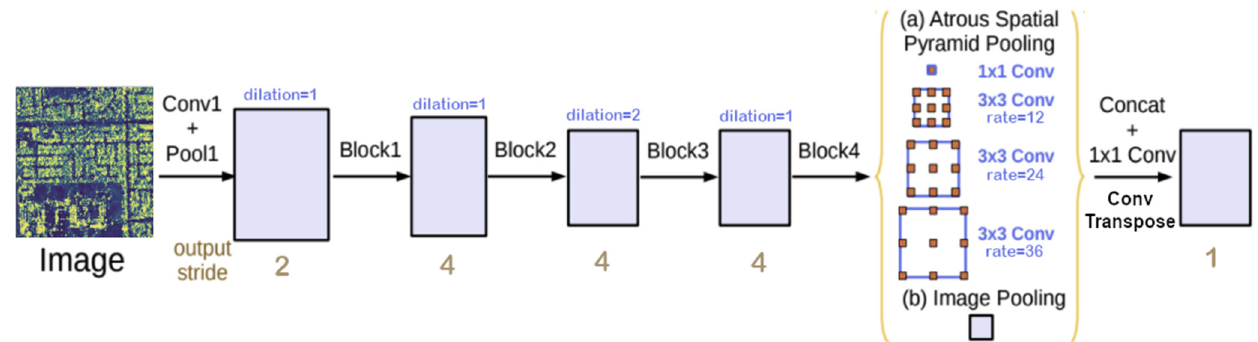
Figure 2. Our modified DeepLab model. Since roads can have thickness less than the output stride (the number of input pixels represented by one output pixel) of the standard ResNet backbone, we reduce output stride by reducing downsampling in the backbone. We downsample only twice, such that the output stride of the network becomes four. This allows the fine-grain segmentation that we need to extract thin objects such as roads, while the ASPP layer still allows for high-context information to inform local decisions.